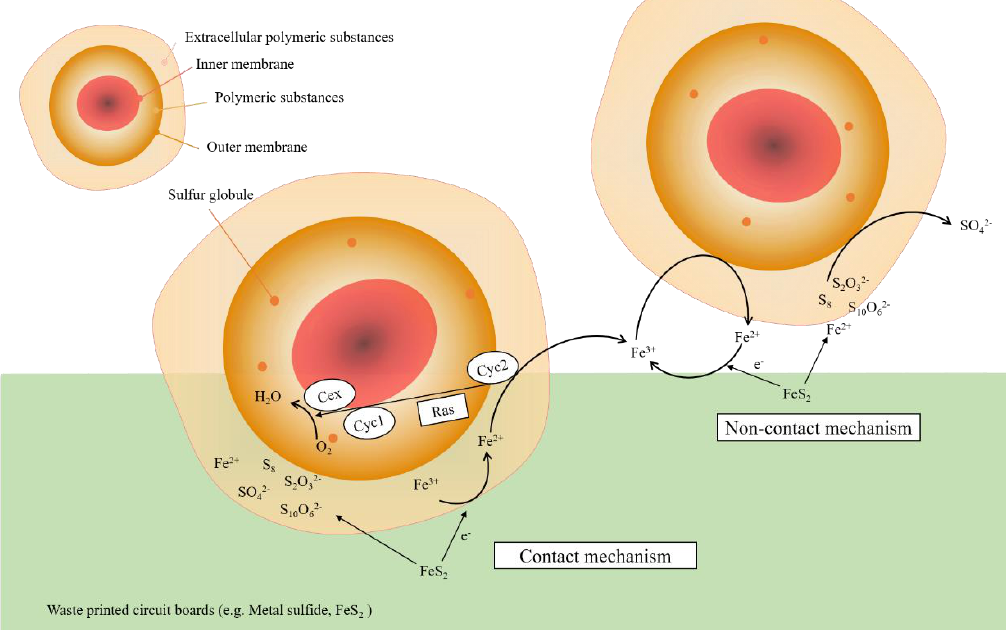
Figure 4. Critical steps in contact and non-contact mechanisms[28].